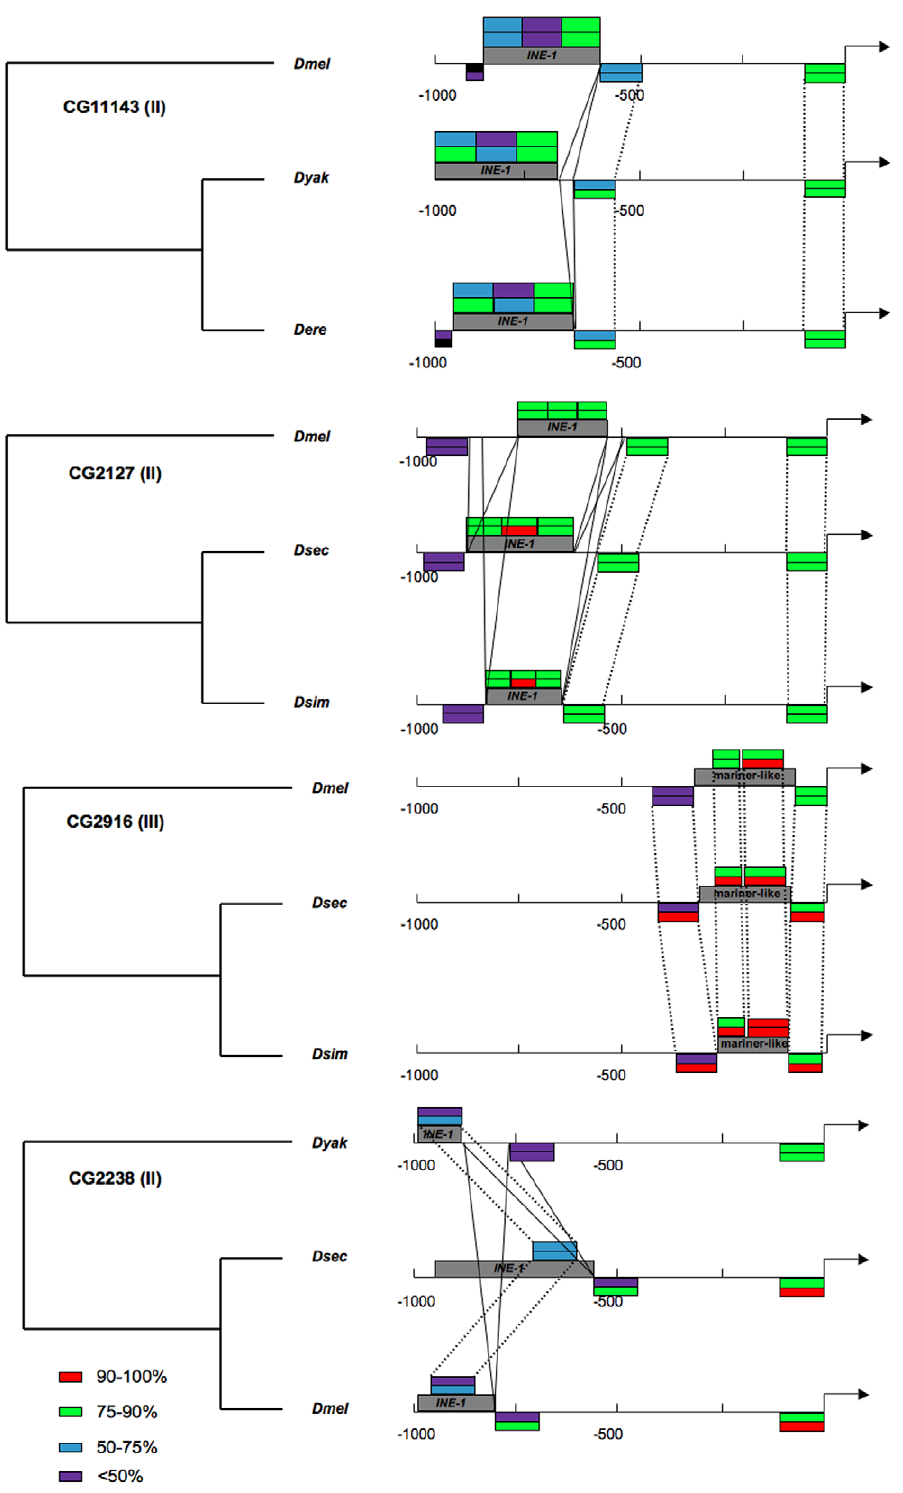
Figure 3. Representative subset of TE insertions in promoter regions shared among 3 species. Sequence conservation of TE and TSS flanking regions is indicated as % pairwise divergence based on Tamura-Nei distance calculated over a 100bp interval of CLUSTAL alignment. Pairwise sequence divergence of TE is based on three equal sized sections of CLUSTAL alignment for CG11143 and CG2127, where elements are of similar size. Solid lines indicate larger indels and dashed lines connect homologous sequence blocks. In CG2916 and CG2238, TE conservation is calculated over conserved blocks corresponding to the smallest element size amongst the three species. The synteny among elements and flanking sequence suggests that these elements are the product of singular insertion events prior to the divergence of the daughter species in which they are currently detectable.